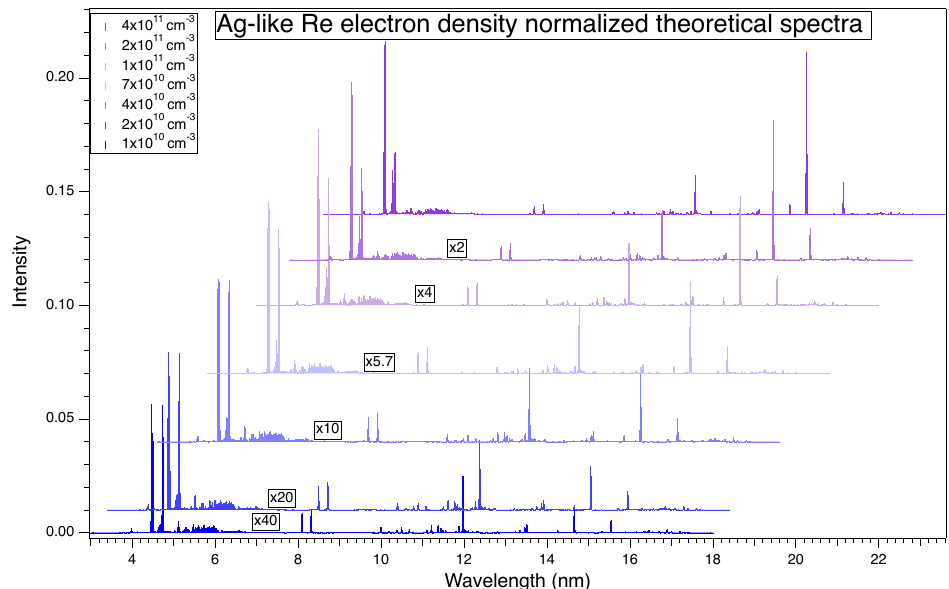
Figure 3. NOMAD collisional–radiative [9] calculations of Ag-like spectra at 1.5 keV electron beam energy and electron densities between 1 × 10 10 cm − 3 and 4 × 10 11 cm − 3